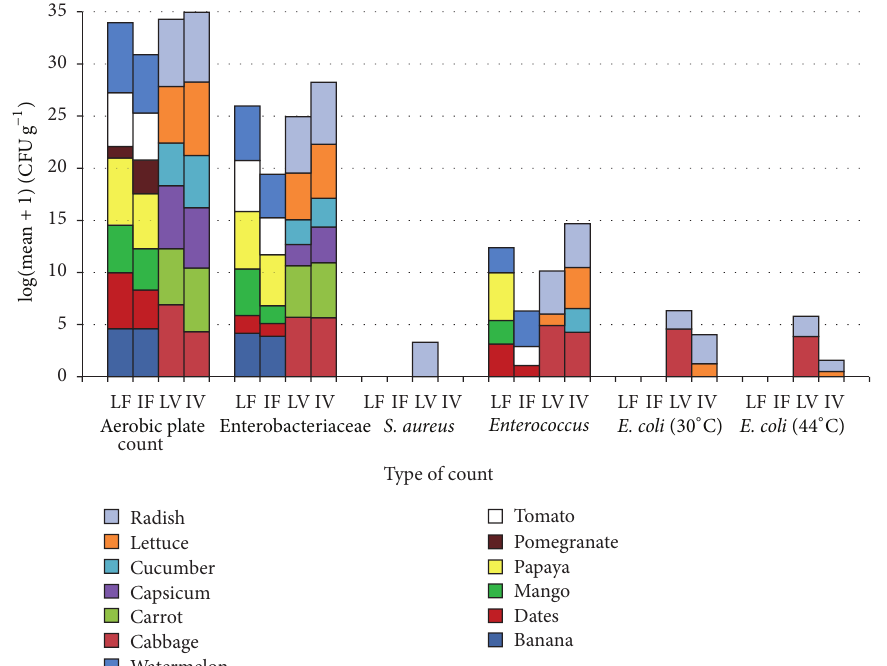
Figure 1: Microbial counts (log (mean + 1) CFUg −1 ) in local fruits (LF), imported fruits (IF), local vegetables (LV), and imported vegetables (IV).